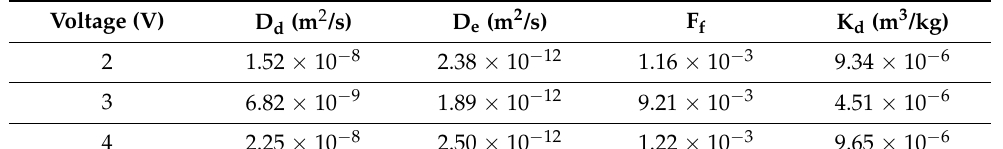
Table 8. Parameter evaluation of the breakthrough curves of Cs + migrating through the rock sample using advection-dispersion model.